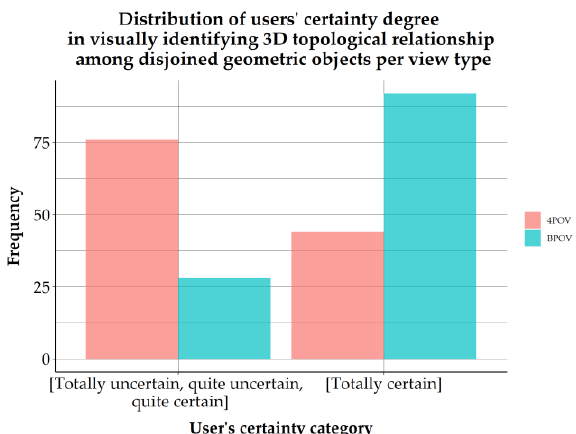
Figure 5: Exact binomial test. Success rate of visual 3D topological relation identification among overlapped geometric objects per view type. 4POV: the traditional software points of view; BPOV: the proposed optimum viewpoint.